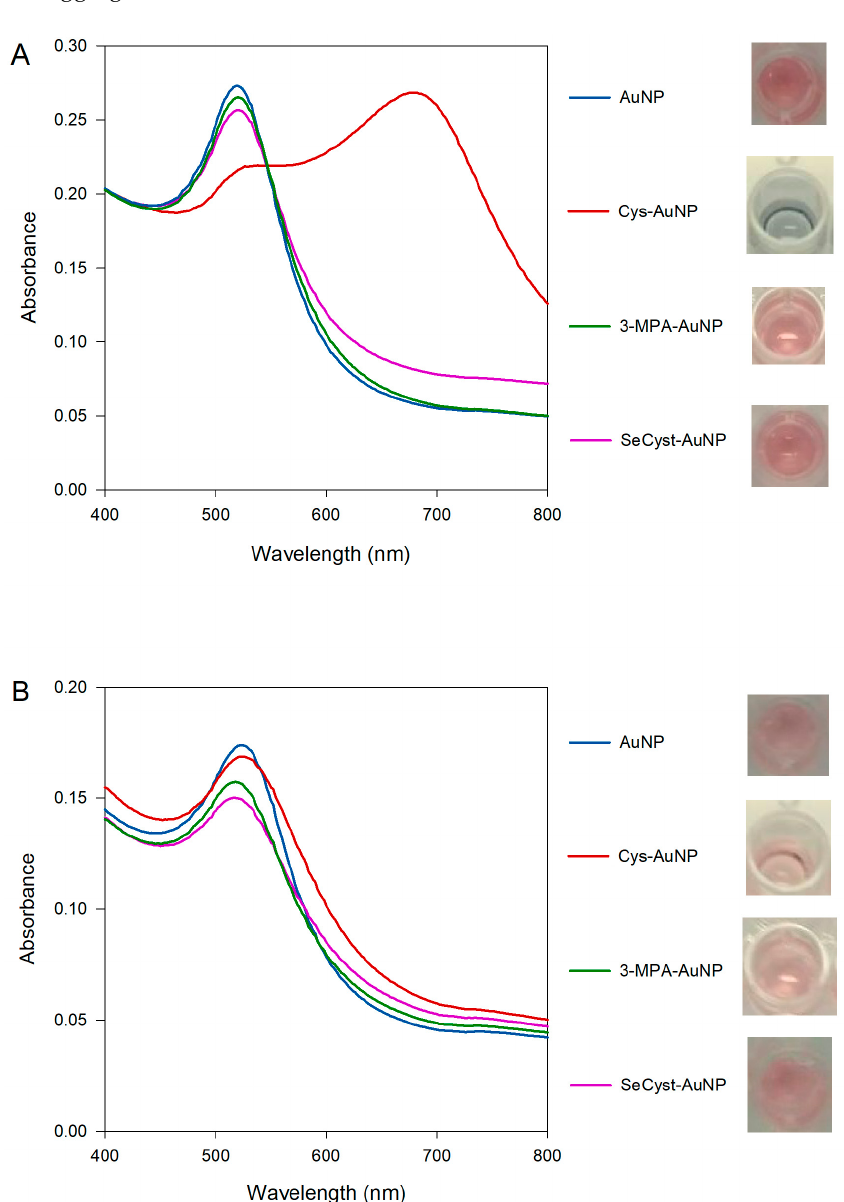
Figure 3. Comparison of the UV-vis spectra and physical appearance of the ( A ) synthesized and ( B ) purchased AuNPs stabilized by citrate and functionalized with Cys, 3-MPA and SeCyst, respectively at pH of approximately 10. Table 2. Comparison of the SPR band λ max values of synthesized and purchased AuNPs stabilized by citrate and functionalized with Cys, 3-MPA and SeCyst, respectively at pH of approximately 10. Synthesized AuNPs Wavelength (nm)